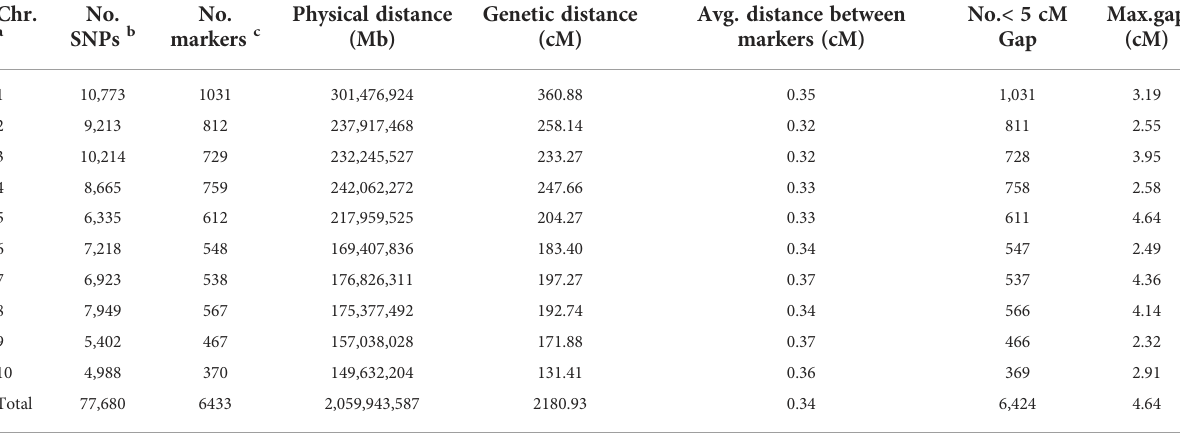
TABLE 2 Characteristics of the high-density genetic map derived from a cross between Ji846 and Ye3189. Chr.